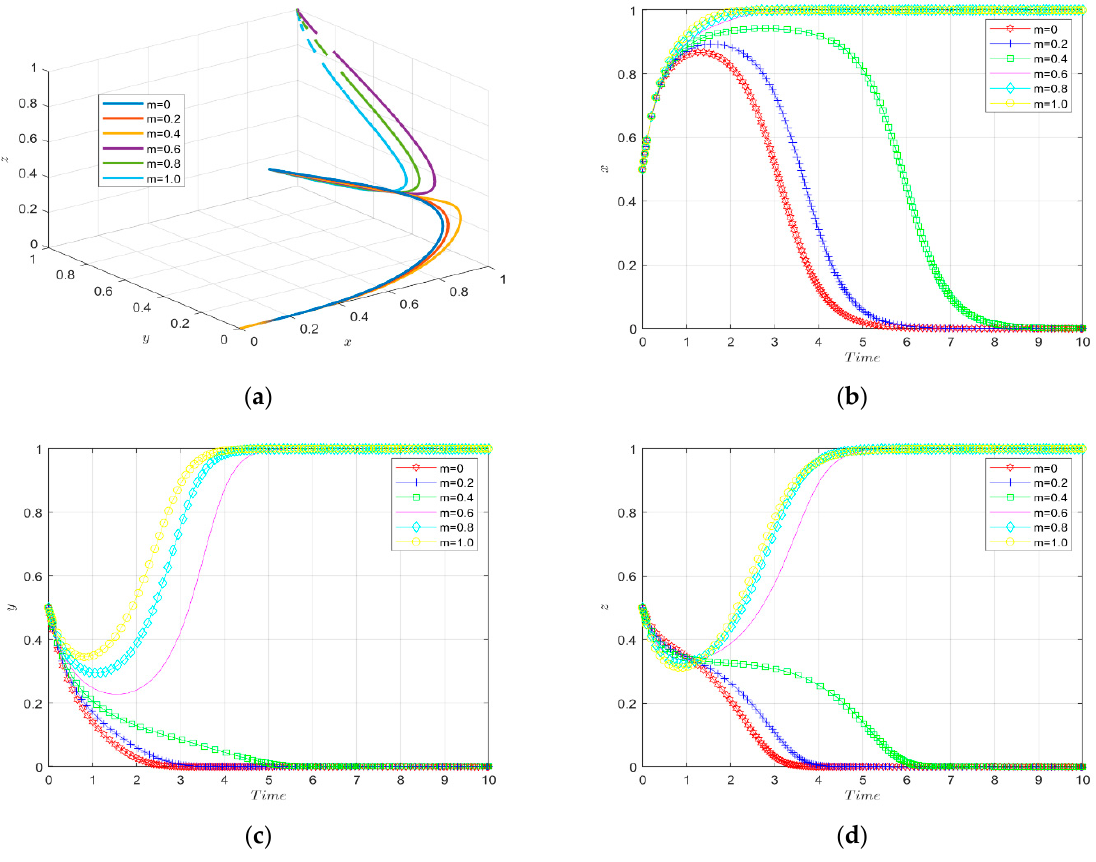
Figure 12. ( a ) Evolutionary trajectory of the tripartite game under different penalty intensities. Evolutionary trajectories of enterprises ( b ), government ( c ) and financial institutions ( d ) under different penalty intensities.